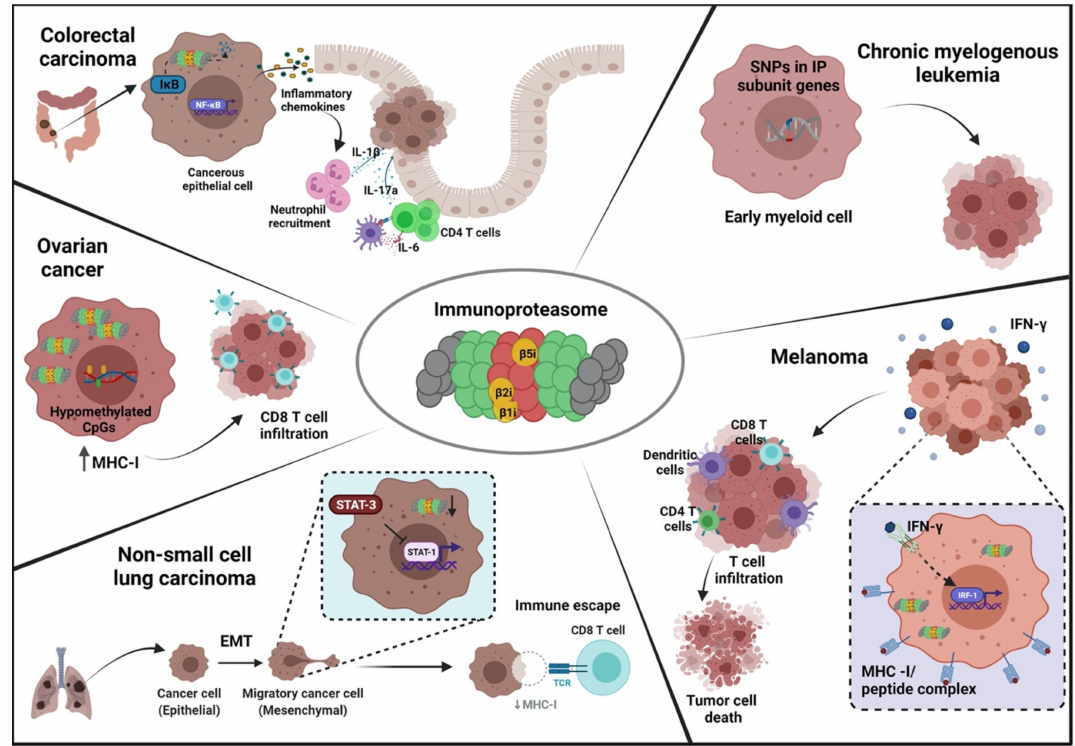
Figure 1. Schematic overview depicting various mechanisms of immunoproteasome participation in different